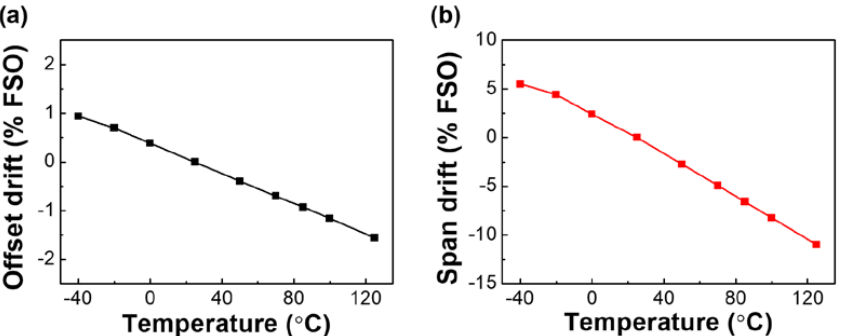
Figure 10. Offset ( a ) and span ( b ) drifts over temperature of bridge circuit outputs. Figure 10. O ff set ( a ) and span ( b ) drifts over temperature of bridge circuit